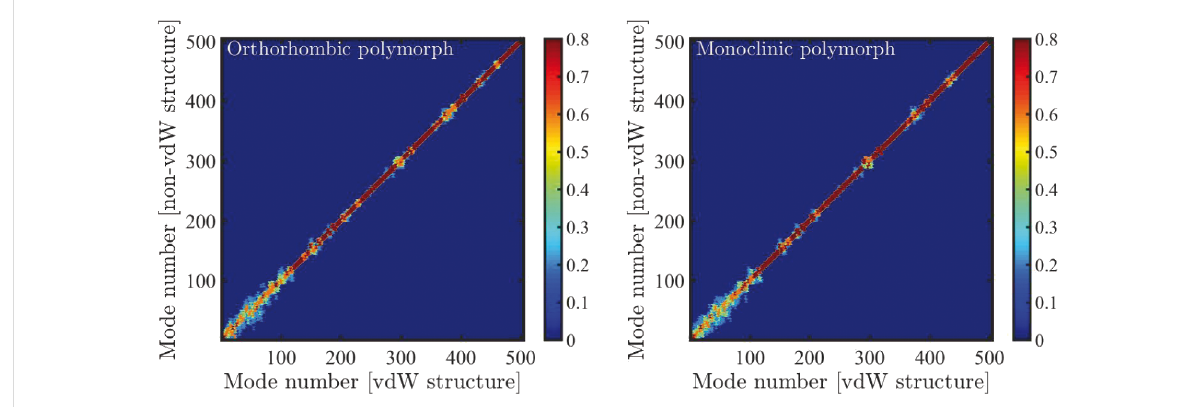
Figure 4: Absolute value of the scalar products between eigenvectors of the mass-weighted Hessian matrix, as obtained with and without TS-vdW pair-wise interactions for both the orthorhombic and monoclinic polymorphs of 2,4,6-trinitrotoluene. Mode no. 125, above which the eigenvectors are very similar with and without pair-wise interactions, is at ca. 8.1 THz for the dispersion-inclusive computation.